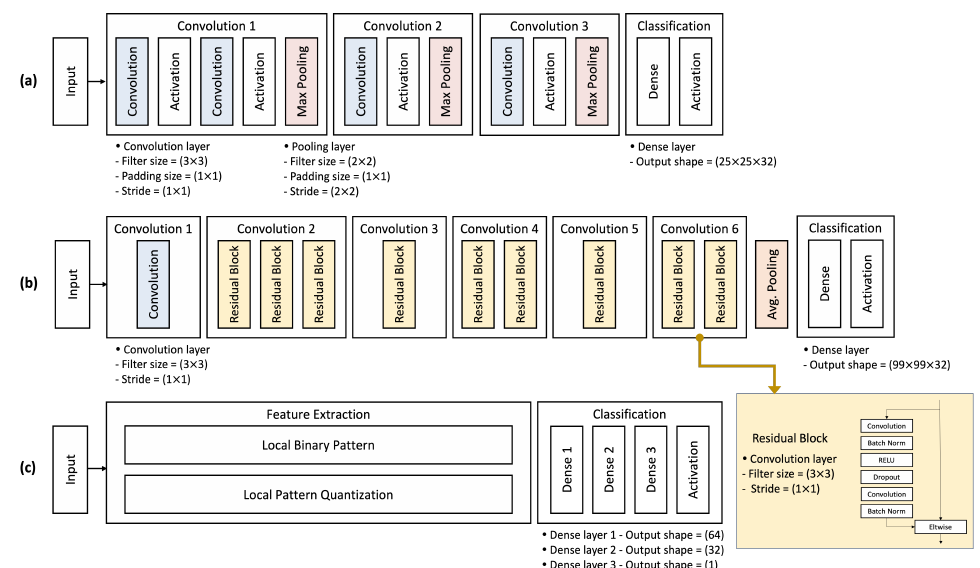
Figure 2. The proposed architecture of CNN#1 ( a ), CNN#2 ( b ), and FNN ( c